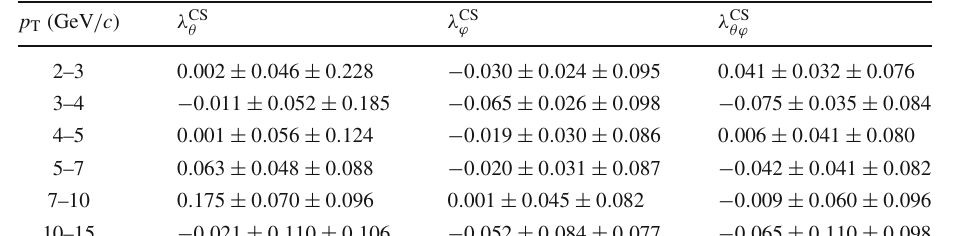
Fig. 4 Inclusive J/ ψ polarization parameters in pp collisions at 8 TeV (black points, error bars represent the total uncertainties) com- pared with model predictions: NLO CSM [10] (blue filled bands), NRQCD [10] (red shaded bands) and NRQCD2 [26] (light blue hatched